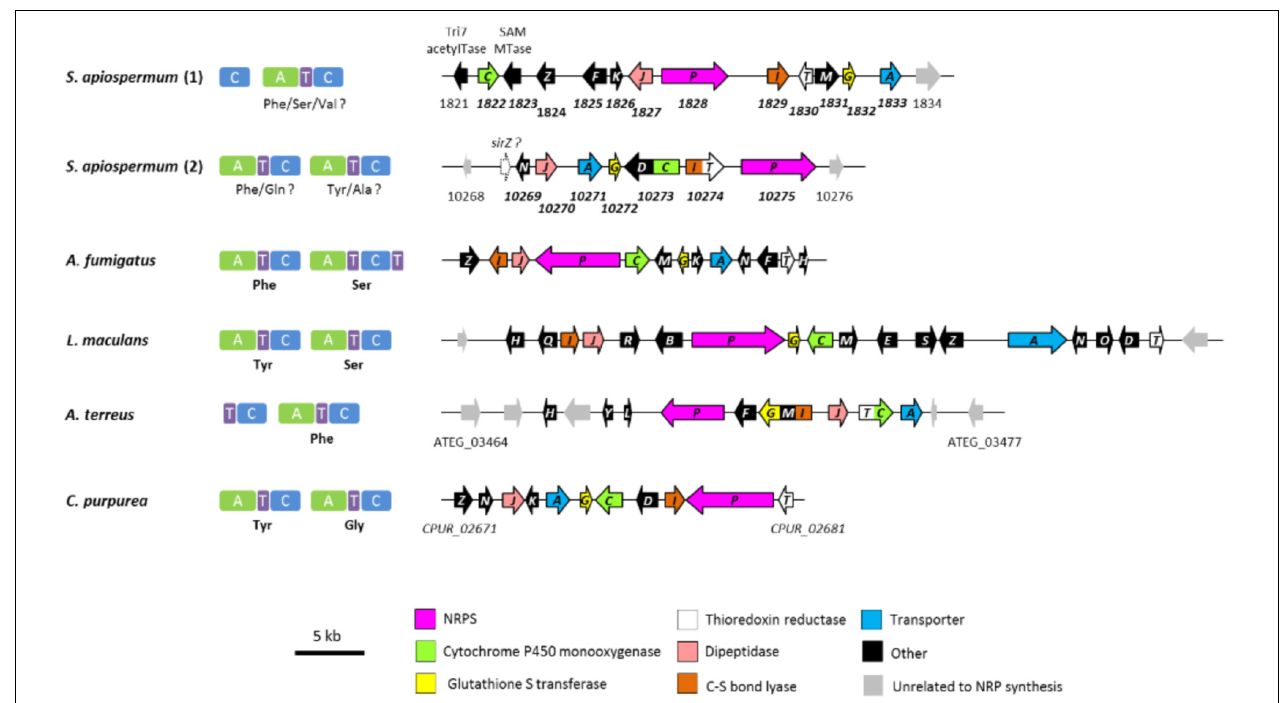
FIGURE 3 | Modular domain structure, substrate specificities and genomic organization of the different biosynthetic ETP-gene clusters. Shown are the ETP gene clusters in S. apiospermum in comparison to the gliotoxin, sirodesmin, acetylaranotin and thioclapurine clusters from A . fumigatus , L . maculans , A. terreus , and C. purpurea , respectively. Orientation of the arrows indicates the direction of transcription. Common ETP moiety genes present in all six clusters are identically colored. The “other” category contains genes encoding a zinc finger transcription factor ( gliZ , sirZ , tcpZ ), cytochrome P450 monooxygenases ( gliF , ataF , sirB , sirE ), prenyltransferases ( sirD , tcpD ), acetyltransferases ( gliH , sirH , ataH ), epimerases ( sirQ , sirR , sirS ), glutamyltransferases ( gliK , tcpK ), methyltransferases ( gliM , gliN , sirM , sirN , ataM , tcpN ), an oxidoreductase ( sirO ), a benzoate p -hydroxylase ( ataY ), and a hypothetical protein ( ataL ). Abbreviations: SAM MTase, S-adenosyl-L-methionine-dependent methyltransferase; Tri7 acetylTase, trichothecene